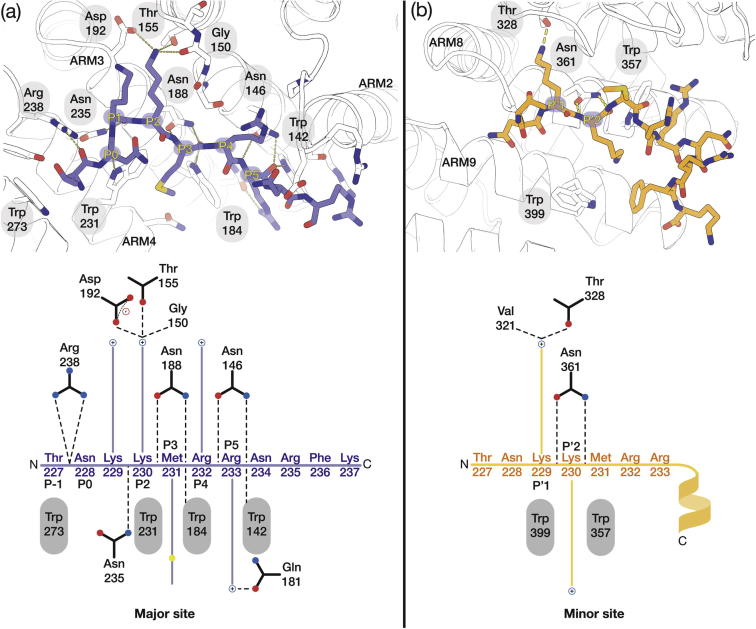
Schematic illustration of the interactions of the HNF1βNLS peptide in the major (A) and minor (B) sites on ΔIBB mouse Importin-α1.